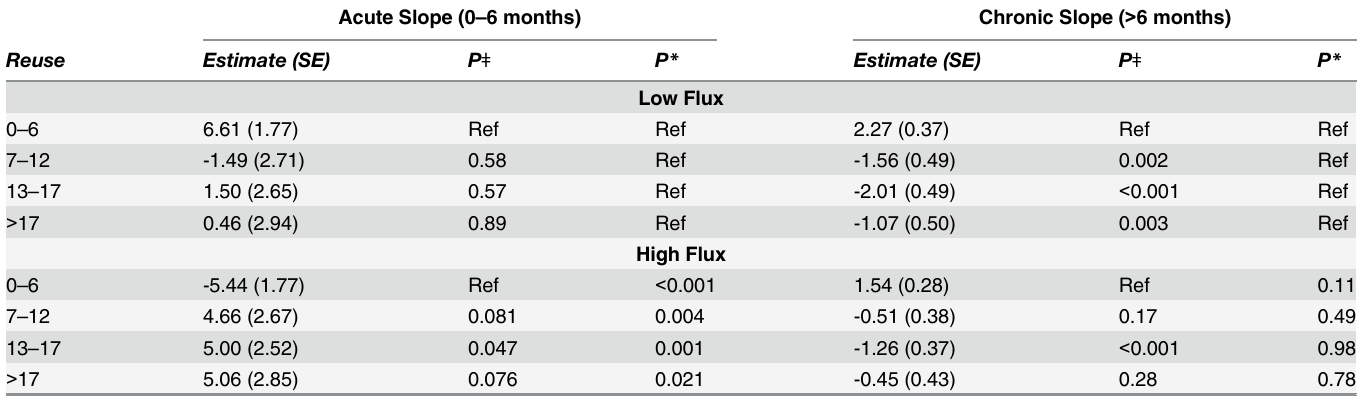
Table 3. Average Acute (first six months) and Chronic Slopes ( > 6 months) of Predialysis β 2M Concentration according to Reuse Quartile and Membrane